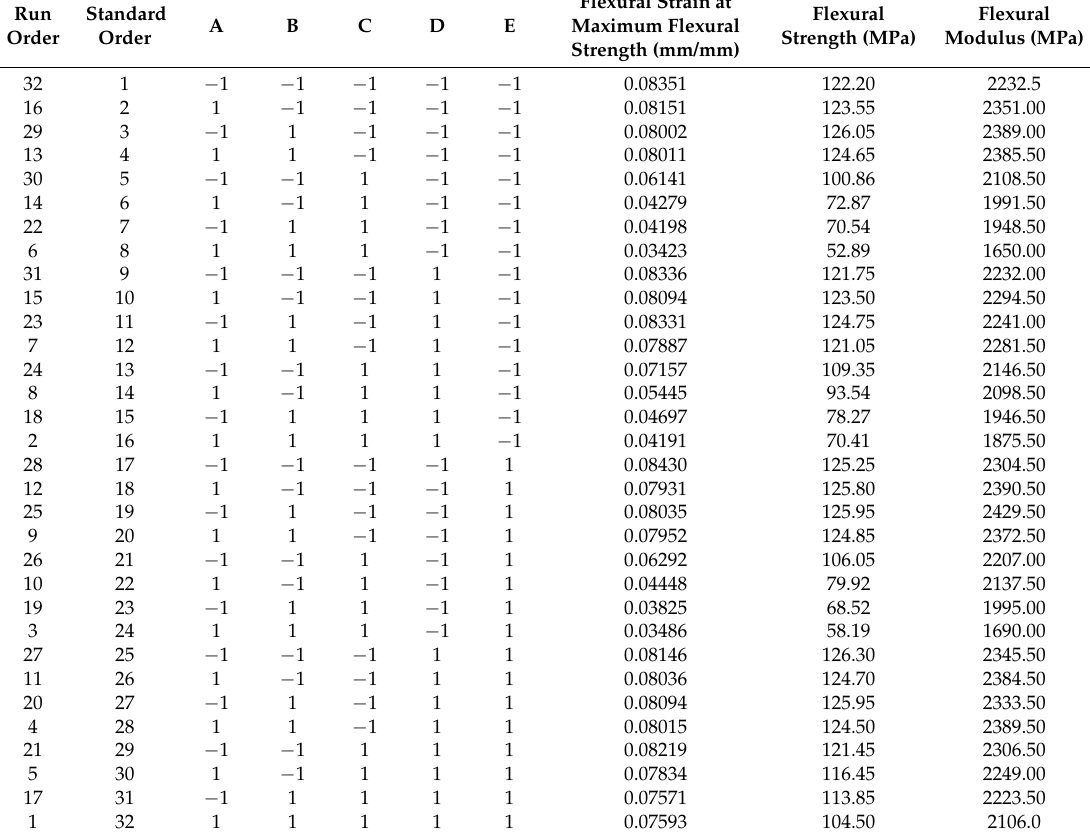
Table 2. Full factorial design matrix with measured values of